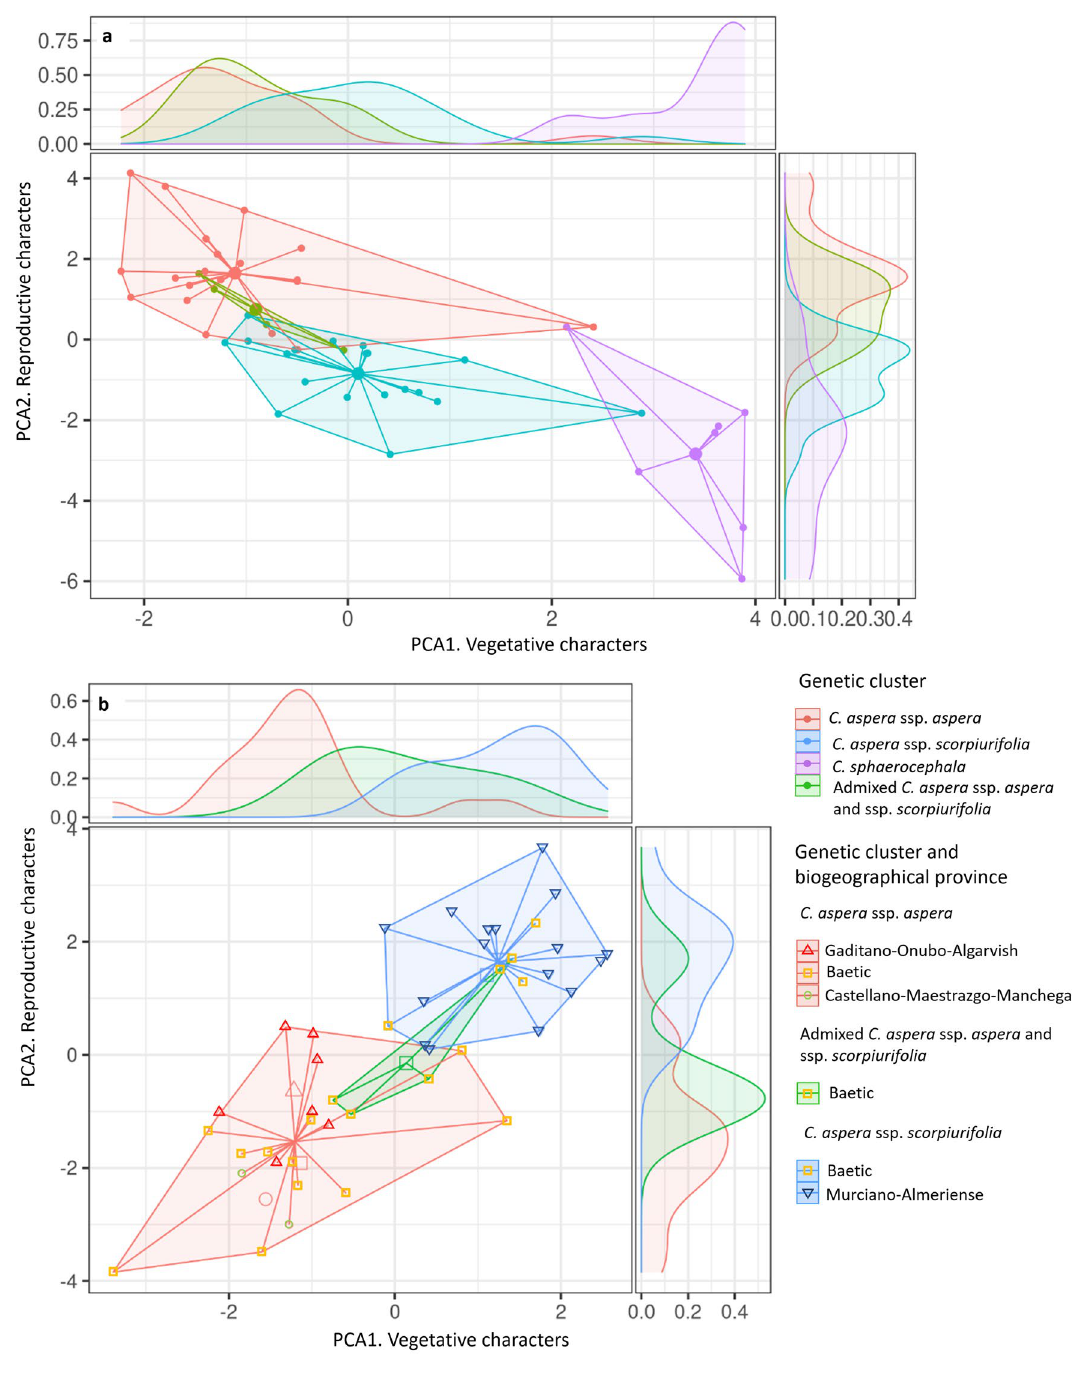
Figure 4. Two-dimensional plot based on the morphology of the sampled plants belonging to the clusters obtained using STRU CTU RE on genetic characterization. The axes of the plot are the first principal components of the PCAs performed using vegetative and reproductive variables. The densities of individuals within each cluster along the two axes are represented. ( a ) Fifty individuals of C. sphaerocephala , ssp. aspera cluster, C. aspera ssp. scorpiurifolia , and 4 admixed between the two latter. ( b ) Forty-three Centaurea aspera individuals (ssp. aspera cluster, ssp. scorpiurifolia , and 4 admixed individuals between